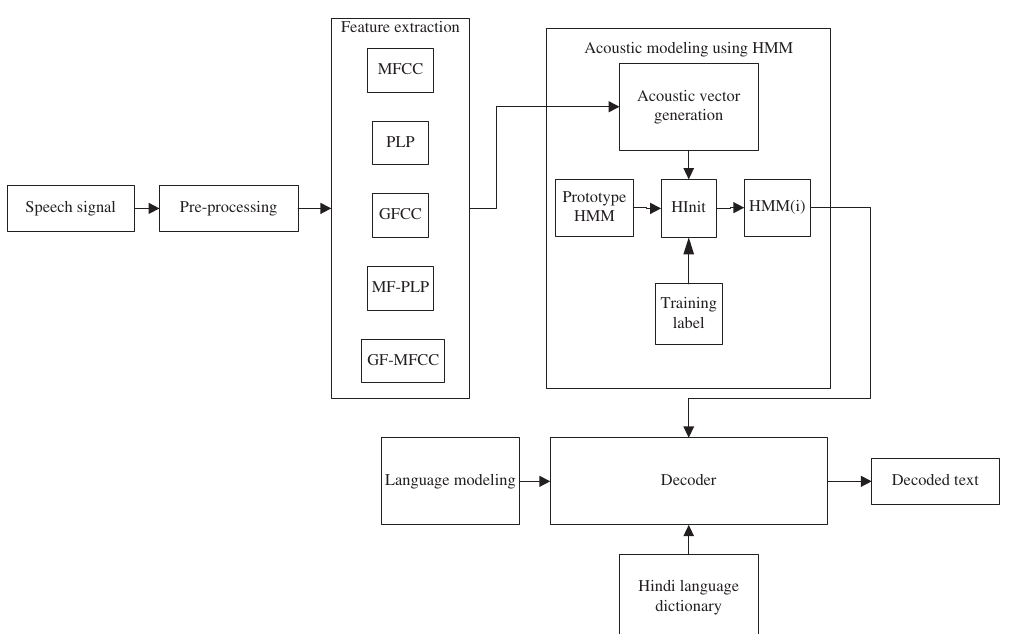
Figure 2: Proposed HMM-GMM-Based ASR System Using Different Feature Extraction